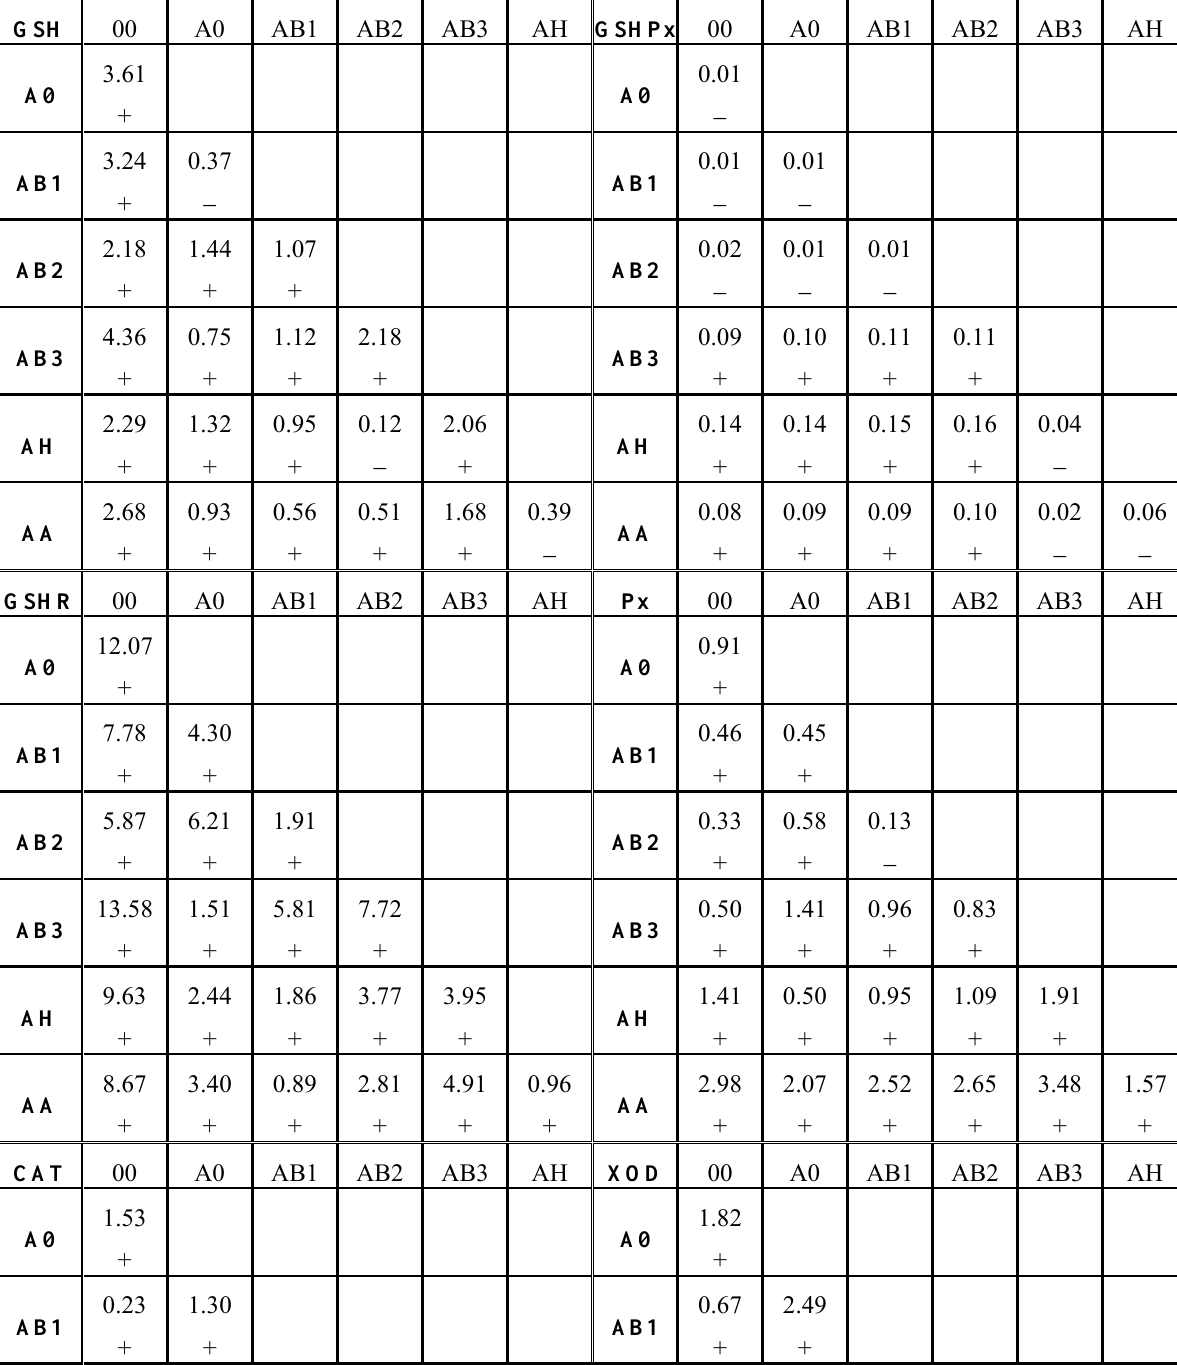
Table 2 . ANOVA test for measured biochemical